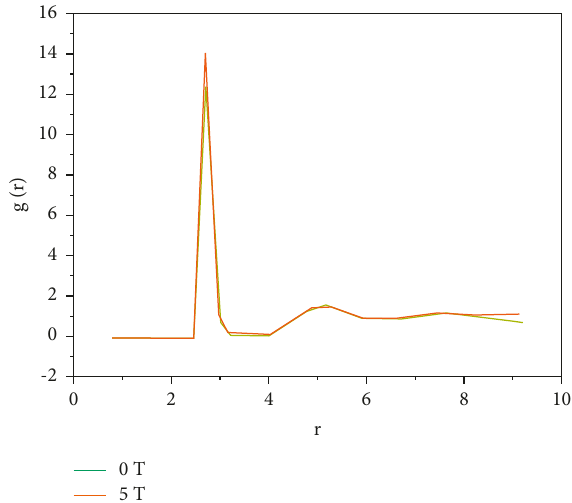
Figure 5: Effect of magnetic field on microstructure of 3.5% NaCl solution g